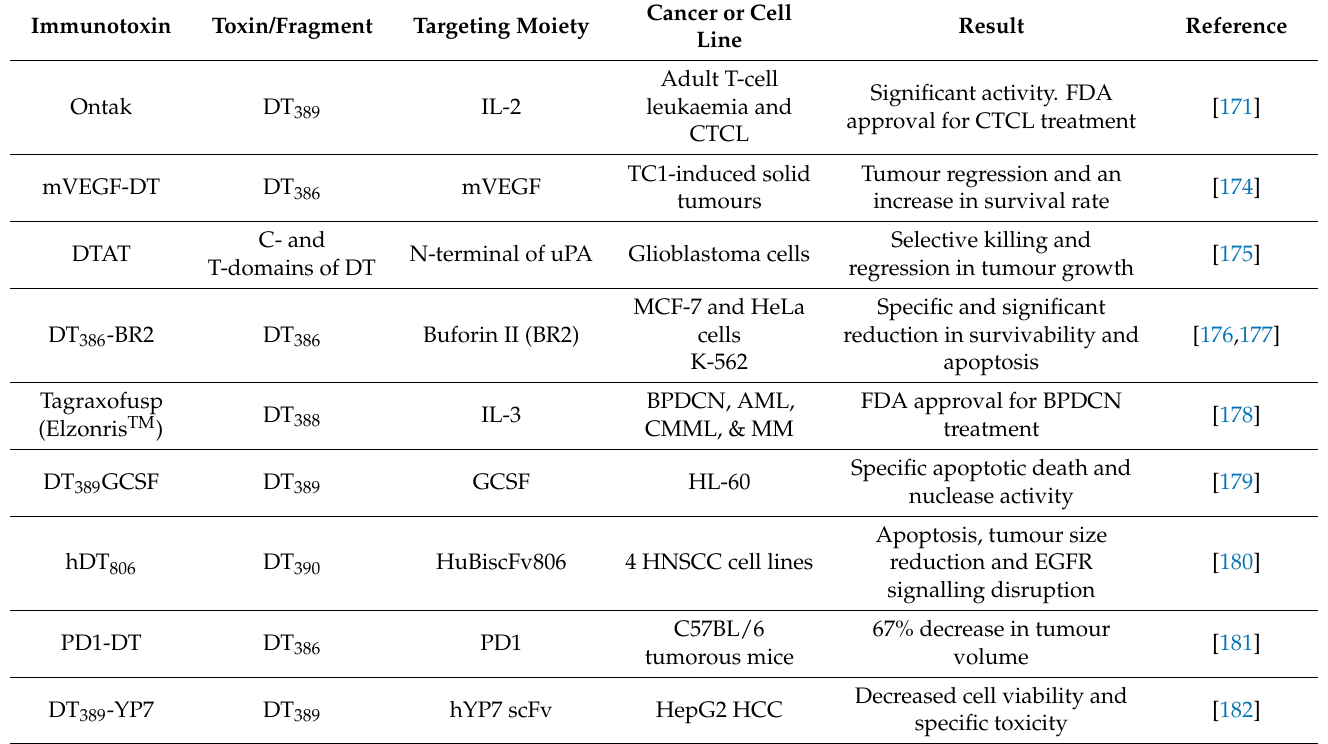
Table 1. Humanized immunotoxins developed from fusion to diphtheria toxin